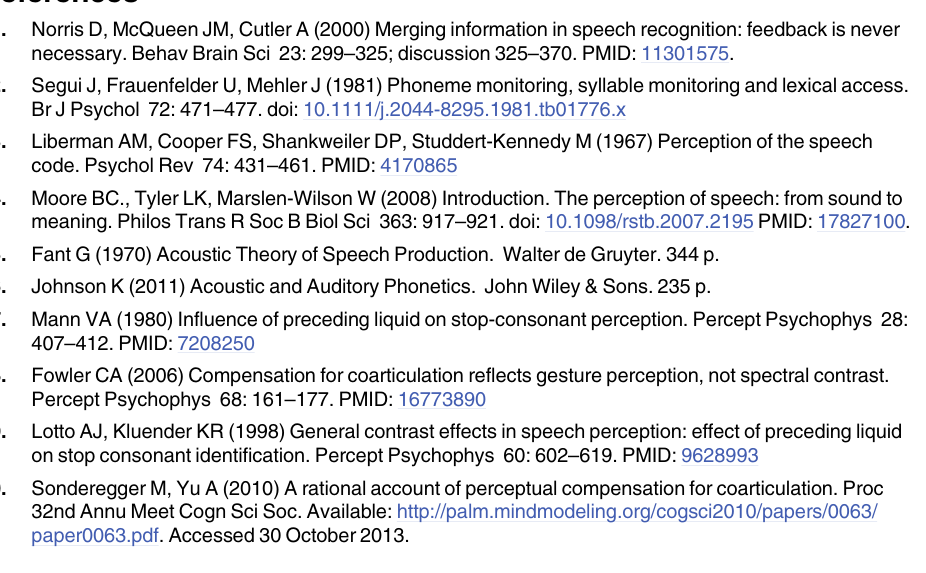
S1 Table. Results of preliminary screening tests for all